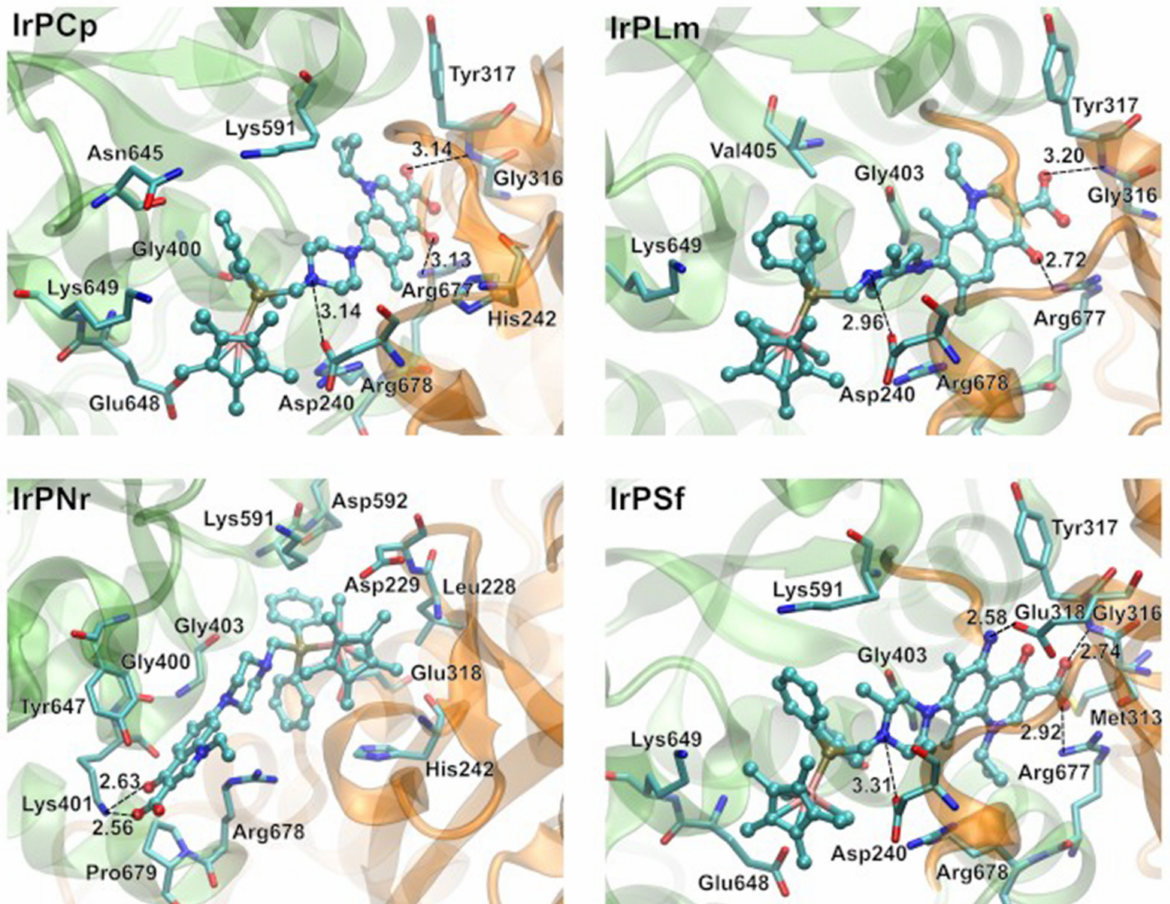
Figure 11. Binding mode of apo-Tf-complexes within the #2 binding pocket. The docked compound’s molecules are shown in ball-and-stick representation. All the apo-Tf residues within 3 Å of the metal complexes are presented in stick representation. The selected distances are given in Å. Hydrogen atoms are not shown for